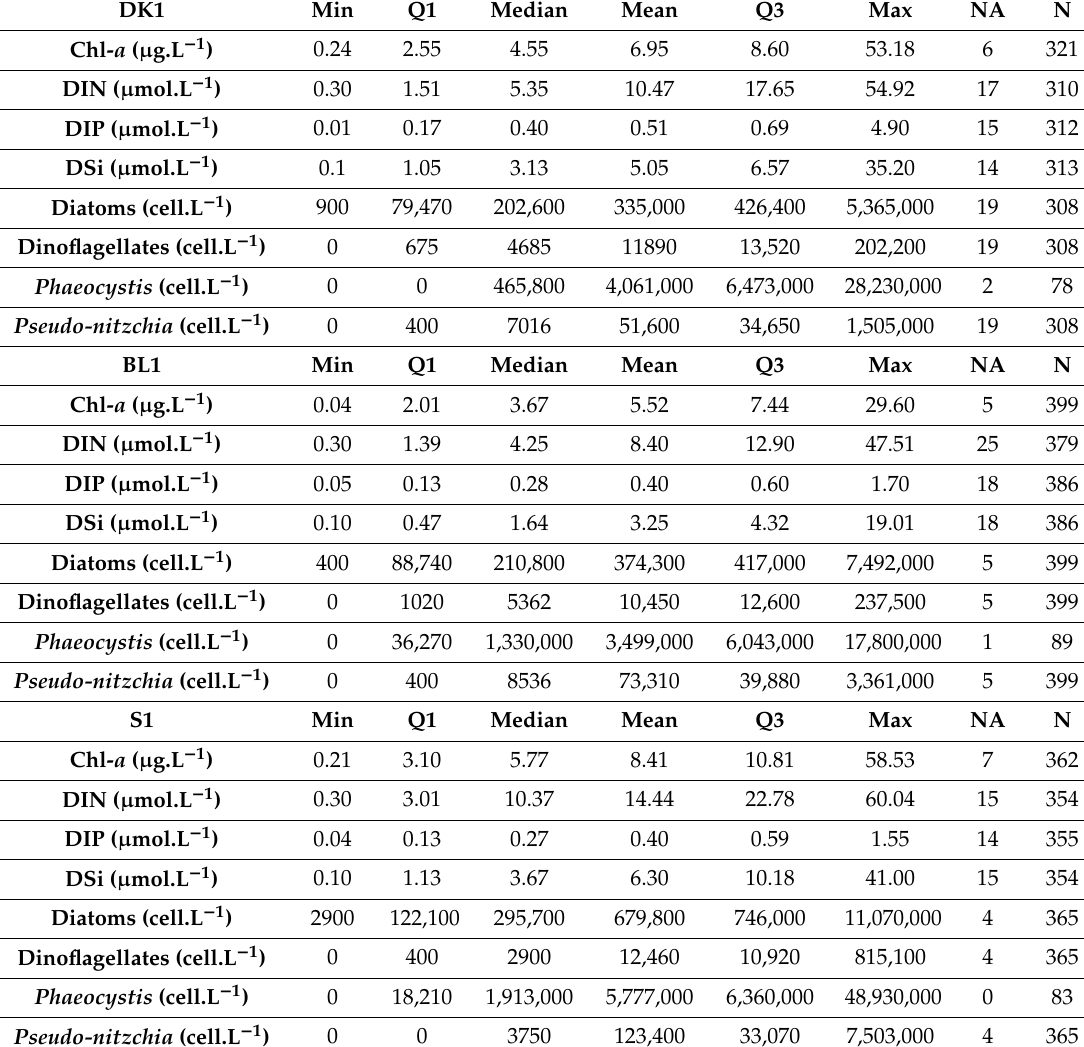
Table 1. Descriptive statistics on raw data from selected coastal stations (DK1, BL1 and S1) and parameters for the period 1994–2018. Minimum, mean, median, maximum, first (Q1) and third (Q3) quantiles, number of missing data (NA) and length (N) of each data series. Phaeocystis : statistics only for April–May.